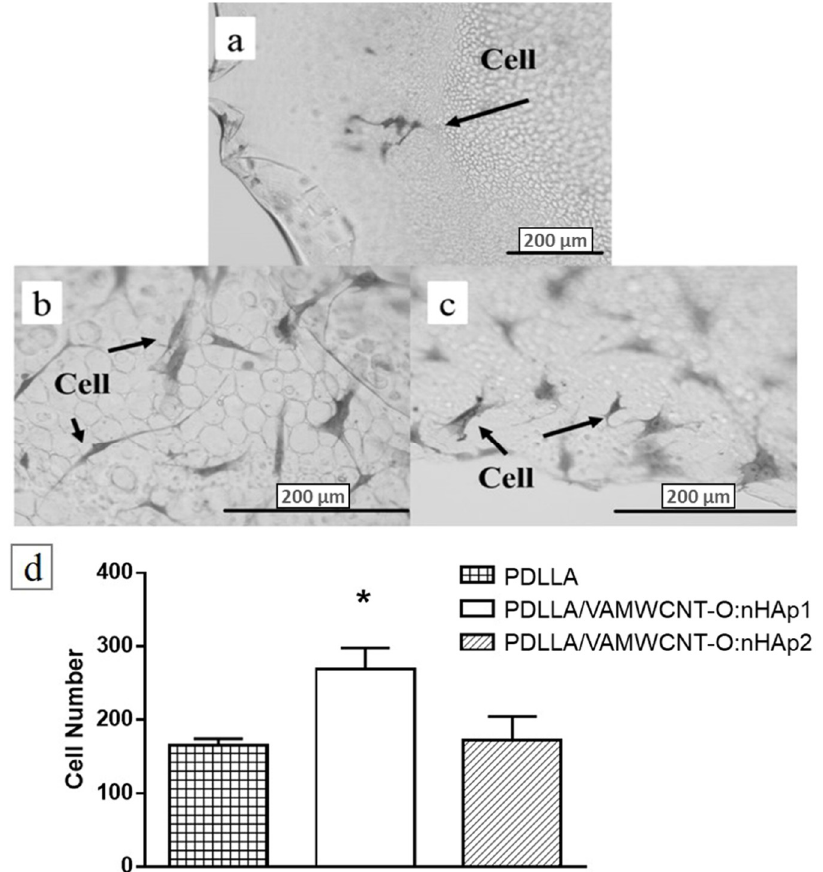
Figure 3. Optical microscopy of the human chondrocytes adhered on ( a ) PDLLA, ( b ) PDLLA/VAMWCNT-O:nHAp1, ( c ) PDLLA/VAMWCNT-O:nHAp2 membranes, ( d ) cell number of chondrocytes attached (N = 3). ANOVA one way with Post-test Tukey’s multiple comparisons test (* p < 0.05, PDLLA/VAMWCNT-O:nHAp1 vs. PDLLA and PDLLA/VAMWCNT-O:nHAp1 vs.